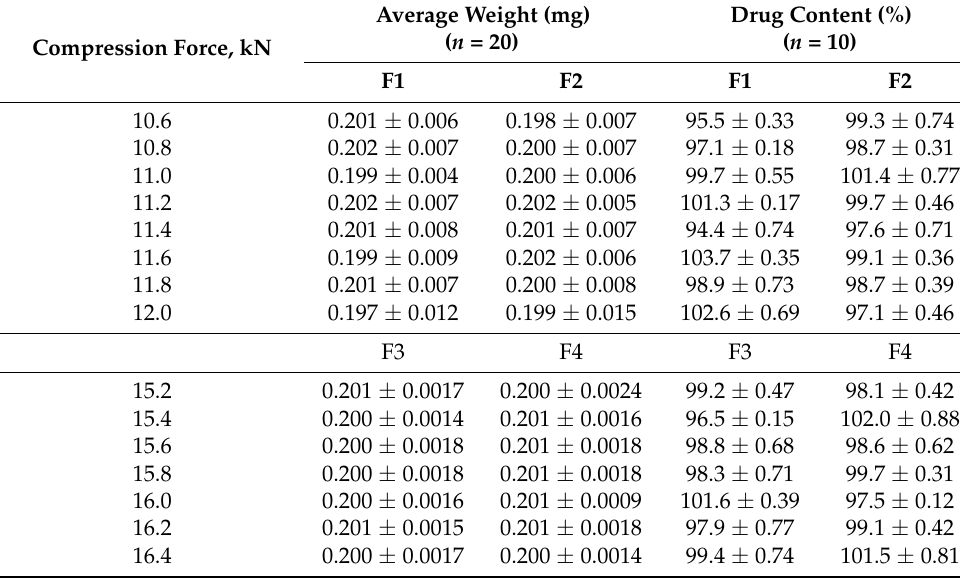
Table 3. Weight variation and drug content of meloxicam